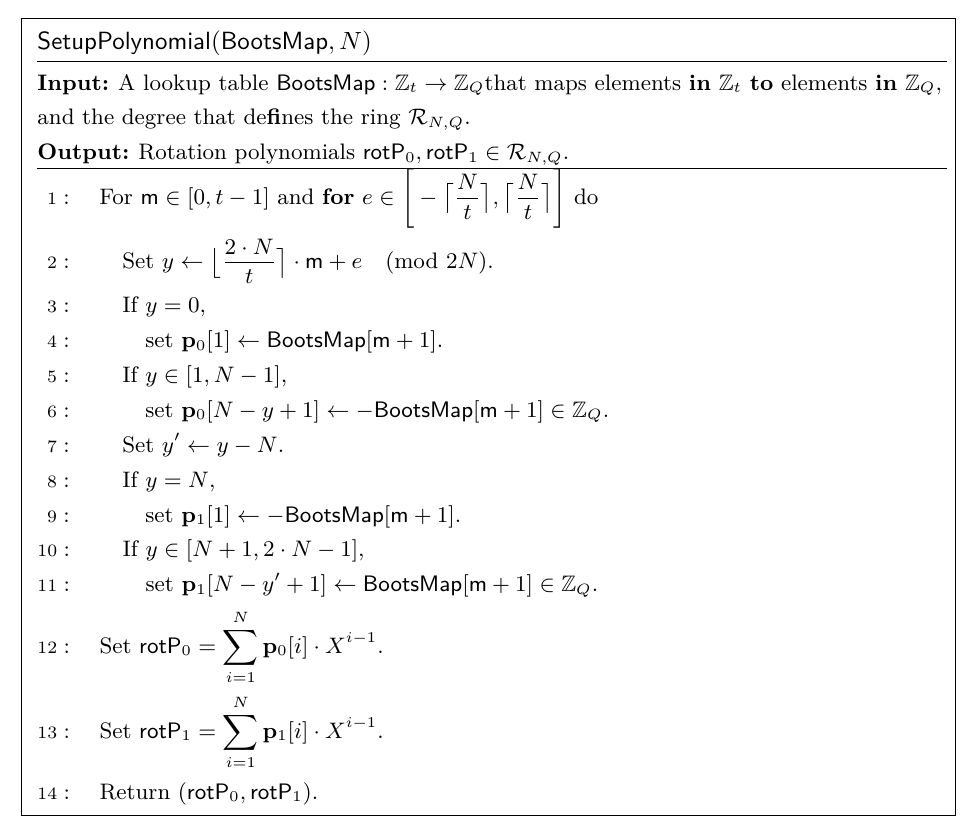
FDFB: Full Domain Functional Bootstrapping